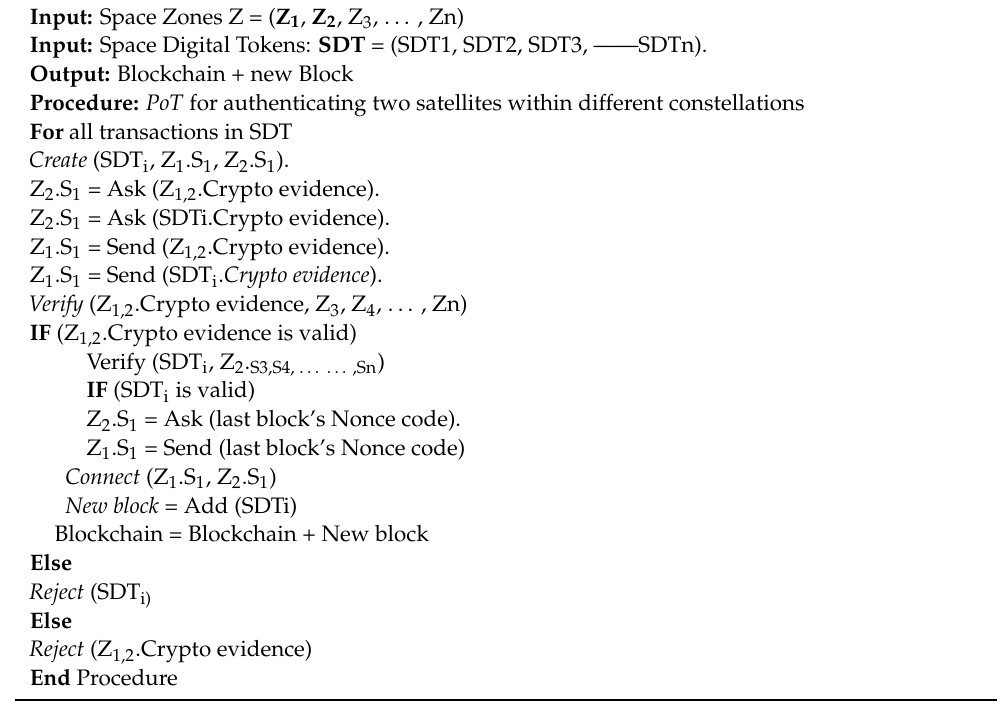
Algorithm 2: PoST for authenticating two satellites within different constellations